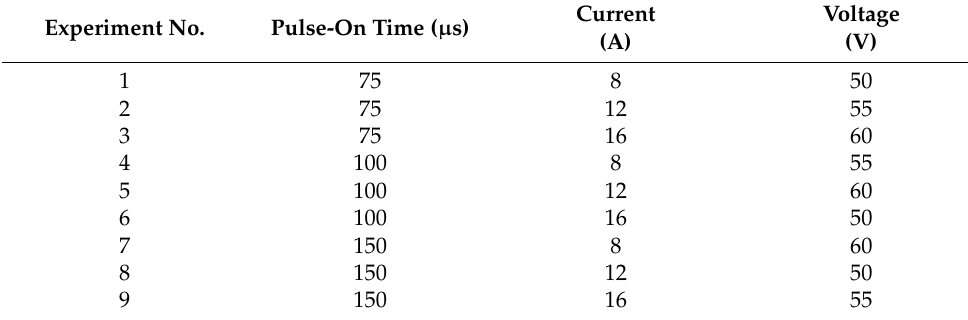
Table 5. L 9 orthogonal array.